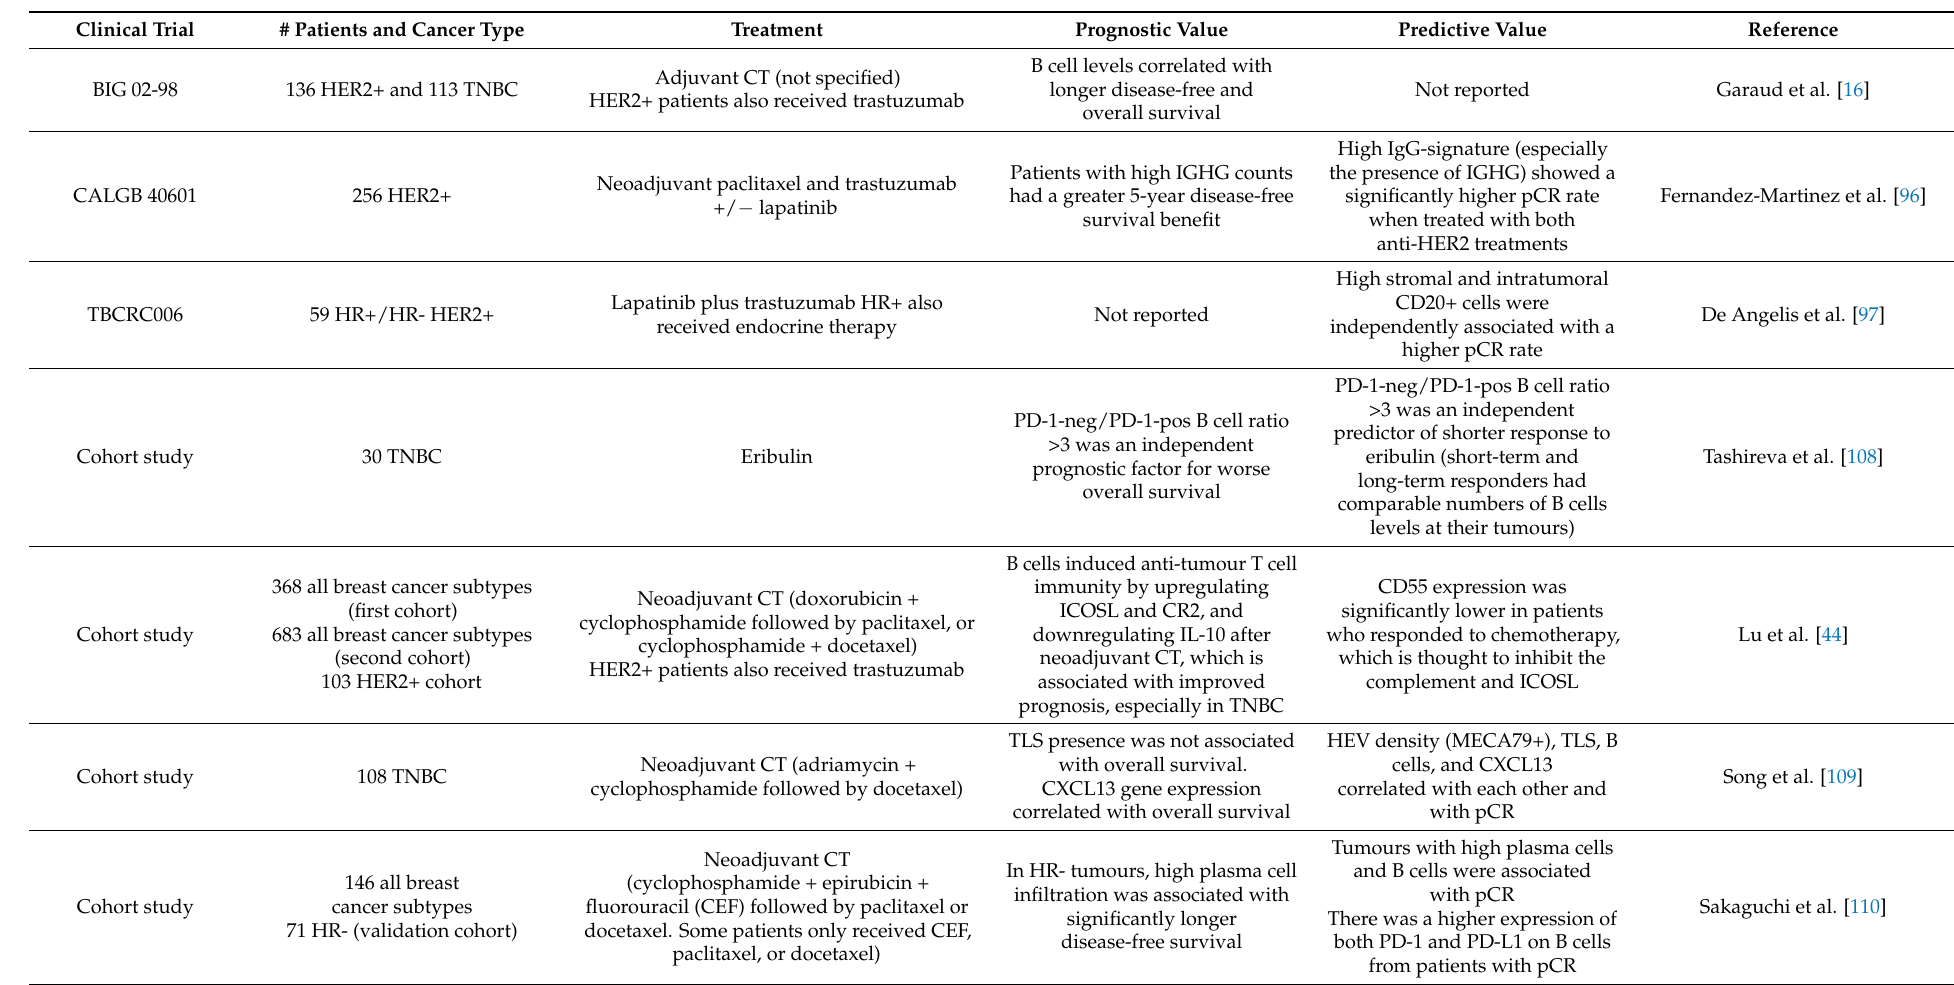
Table 1. Summary of B cell markers, related molecules and histological structures, and their prognostic and predictive value observed in breast cancer clinical trials or retrospective studies from 2017 to